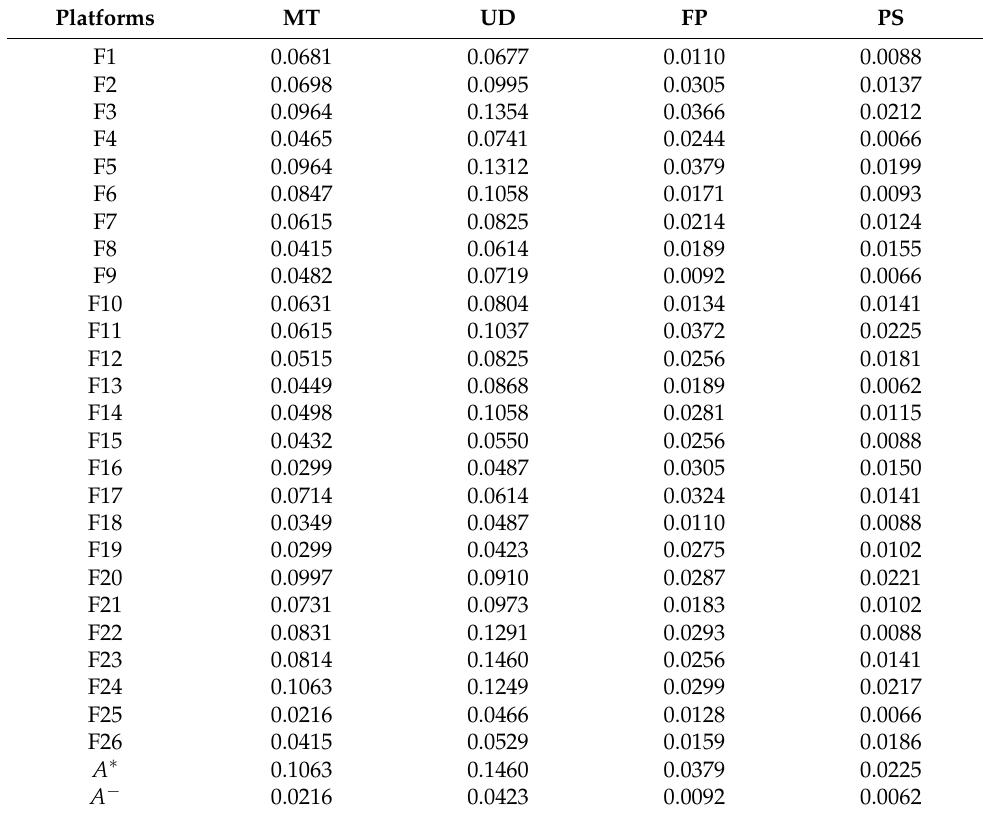
Table 6. Results of the weighted normalized decision matrix.